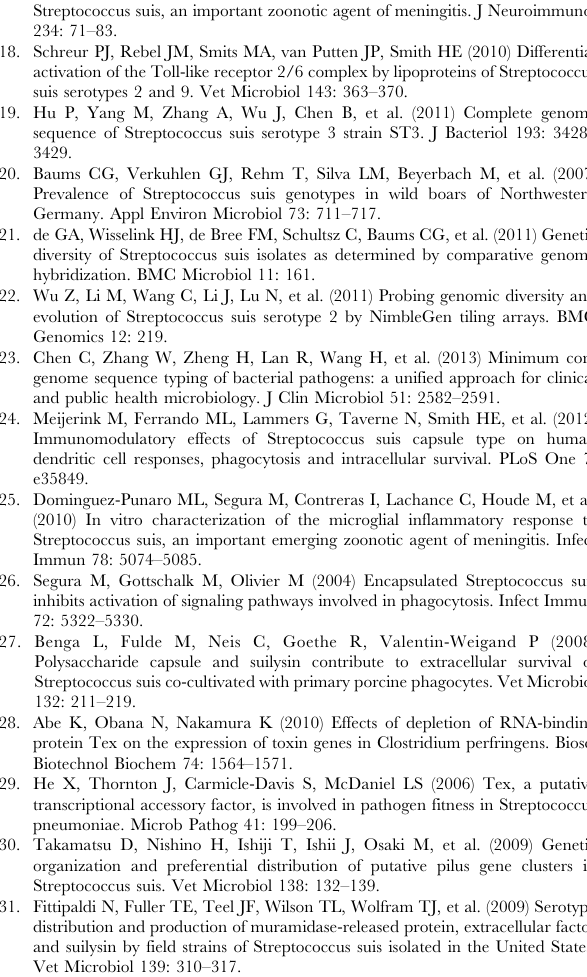
Table S1 Core genes and specific core genes for each group.